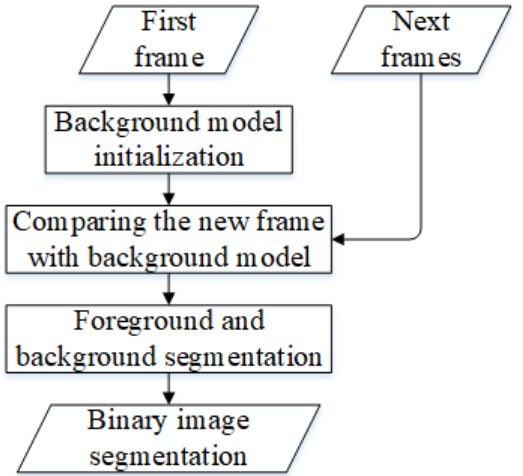
Figure 5. Flowchart of the ViBe conservative update.